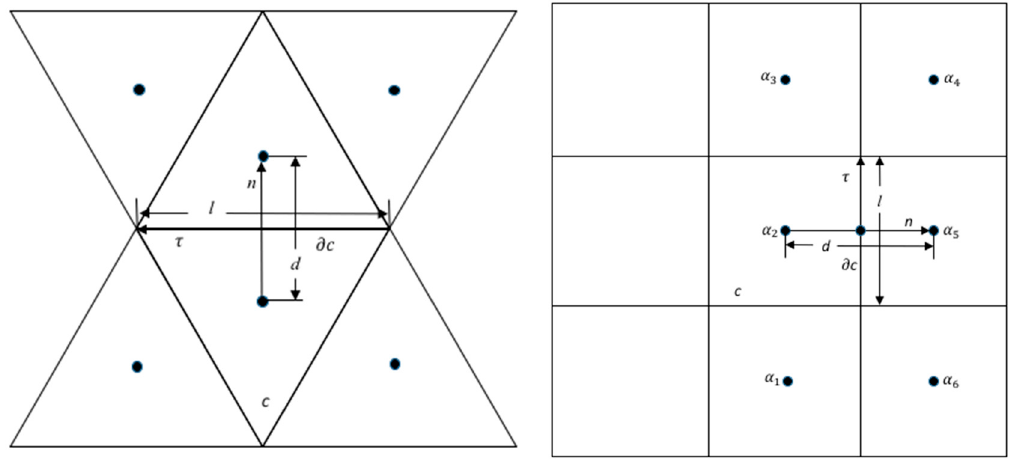
Figure 2. Six-stencil centroidal Z-grid model.